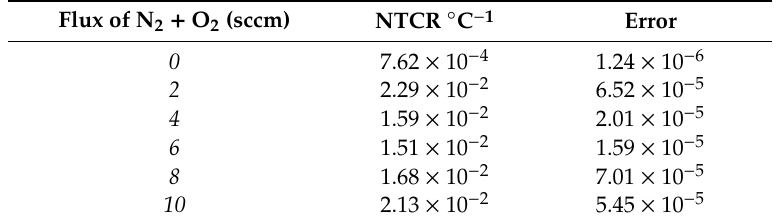
Table 1. Values of NTCR for the TiCu(O,N) thin films sputtered on glass substrates.